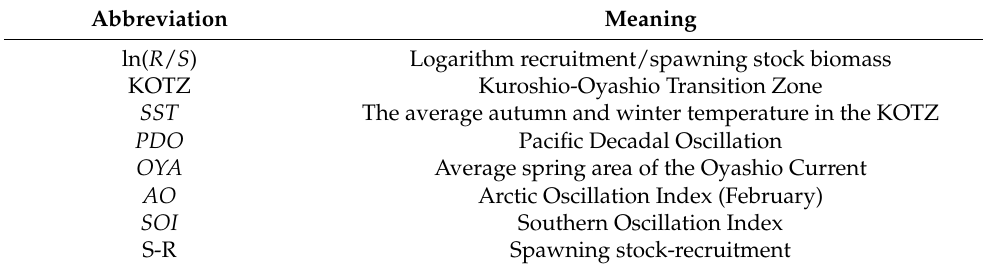
Figure 1. Spawning and feeding grounds of Sardinops melanostictus in the Kuroshio-Oyashio system. Table 1. Data abbreviations used in this study. Table 1. Data abbreviations used in this